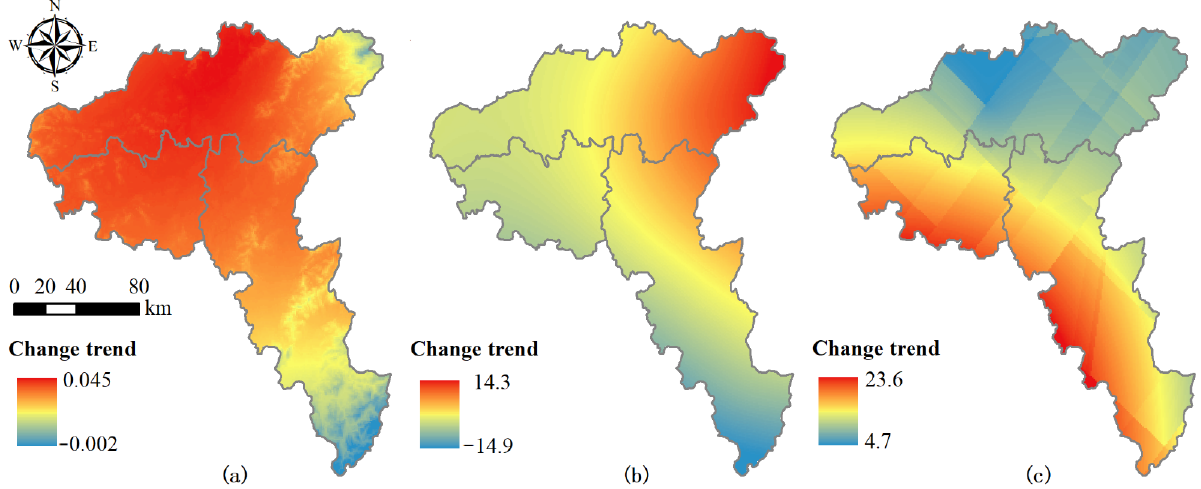
Figure 4. Spatial variation of climate variables in the CZT urban agglomeration from 2000 to 2015. ( a ) Temperature (°C), ( b ) precipitation (mm), and ( c ) radiation (MJ•m − 2 ).